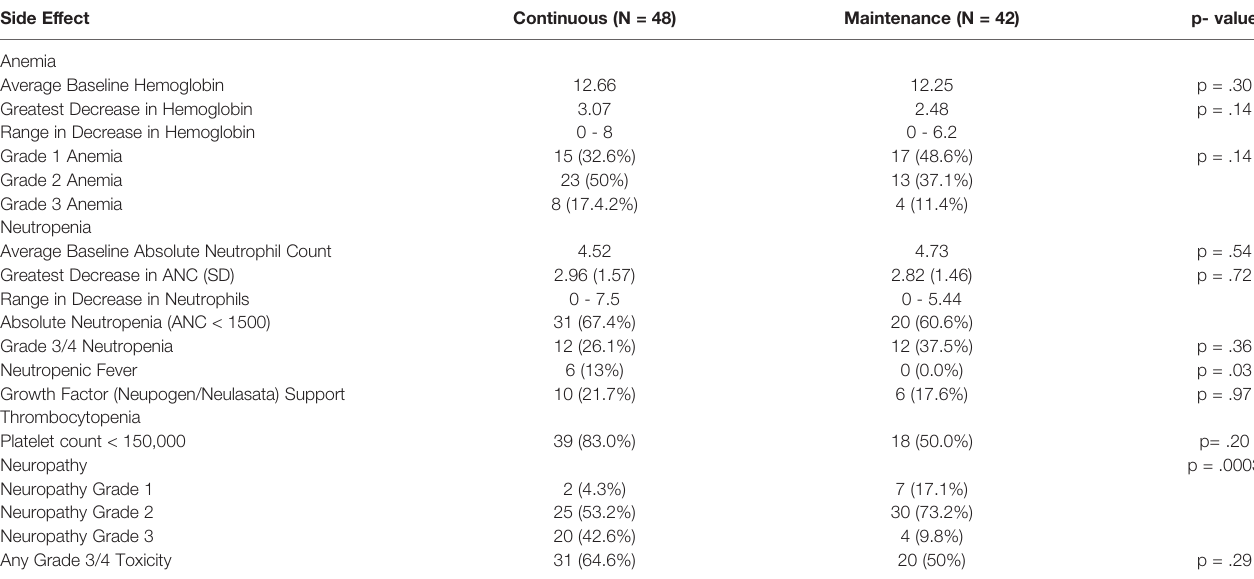
TABLE 2 | Toxicity Pro fi le of Continuous and Maintenance